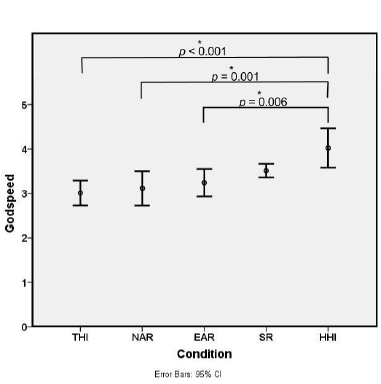
Figure 14: Graph of the Godspeed part of the Subjective Experience questionnaire results among conditions.